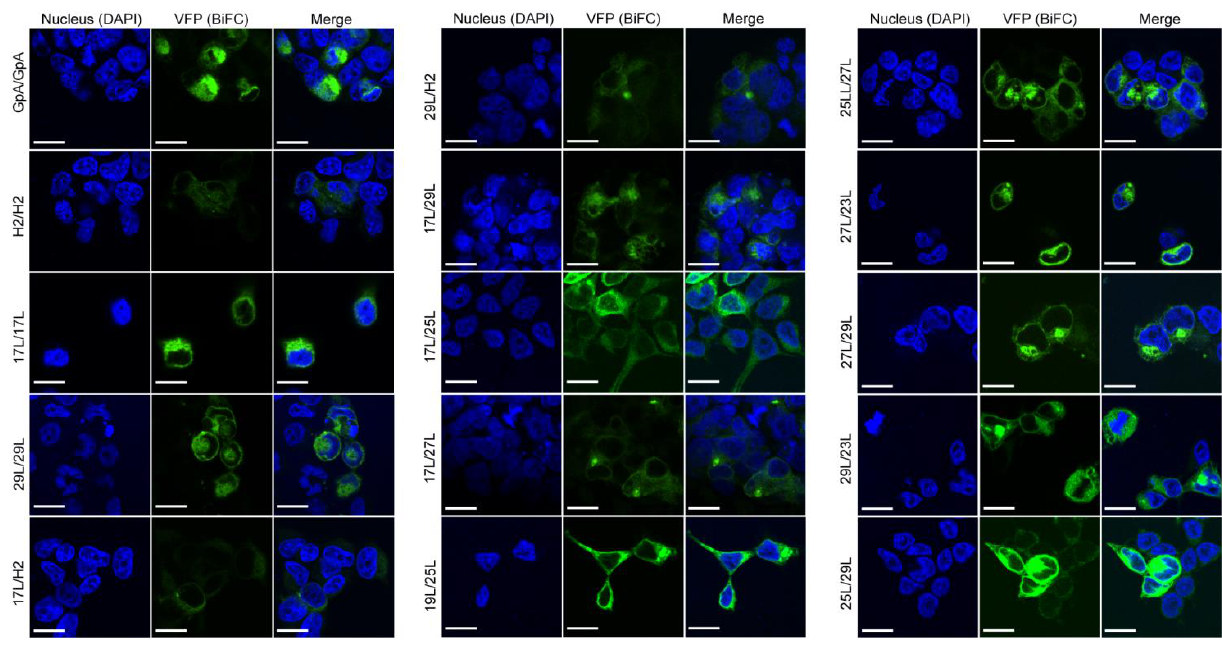
FIGURE 8: Confocal microscopy analysis for membrane dimer formation. Confocal microscopy of DAPI stained (blue) HEK293T cells expressing rep- resentative VN-VC combinations (GpA [VN-GpA/VC-GpA], 17L [VN-17L/VC-17L], 29L [VN-29L/VC-29L], 17L/H2 [VN-17L/VC-H2], 29L/H2 [VN-29L/VC- H2], 17L/29L [VN-17L/VC-29L]). Successful TM-driven oligomerization results in VFP reconstitution and fluorescent signal (green). Scale bar size is 16